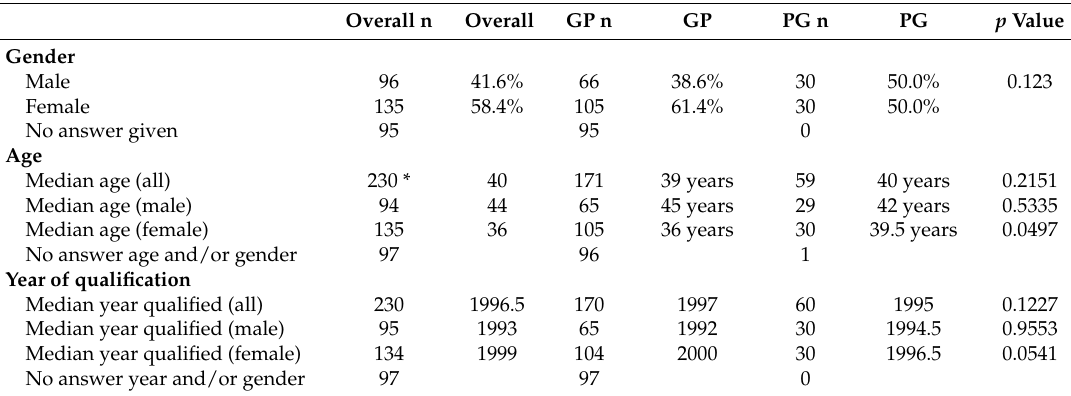
Table 2. Demographic characteristics of GP and PG respondents.